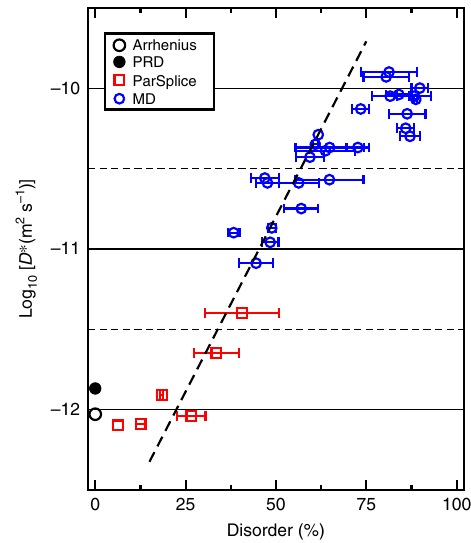
Fig. 2 Non-equilibrium diffusion coef fi cient D ∗ for cations due to vacancy- mediated diffusion in GTO. See text for the description of D ∗ . Points were obtained using PRD, ParSplice, and MD, as well as predicted from static calculations (see text), and are plotted as a function of cation disorder. The width of the horizontal segments re fl ect the decrease in disorder observed in the material during the course of the given simulation. The dashed line is a linear fi t to the data in the interval y = 25 –